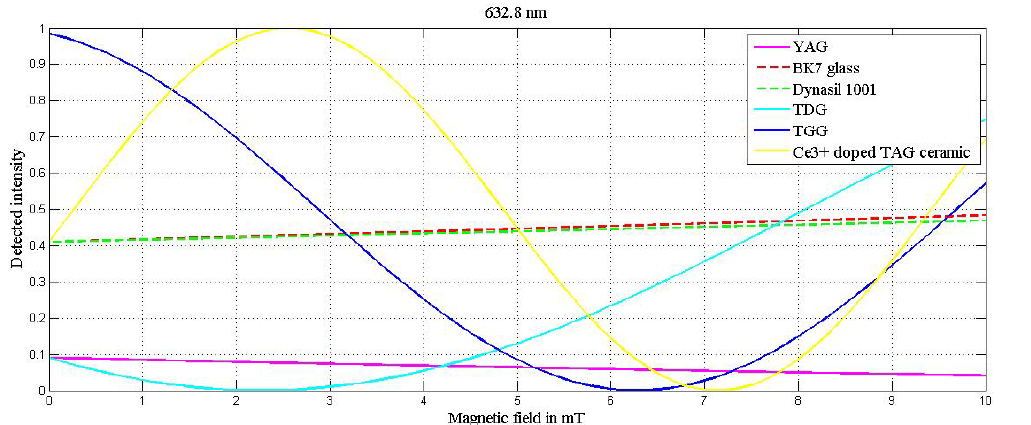
Figure 5. Detected intensity versus magnetic field curve at 632.8nm wavelength of YAG, BK-7 glass, fused glass, TGG, TDG and Ce 3 + doped TAG ceramic for analyzer angles 49, 48, 48, 47, 49 and 48 ◦ , respectively (Table 5).